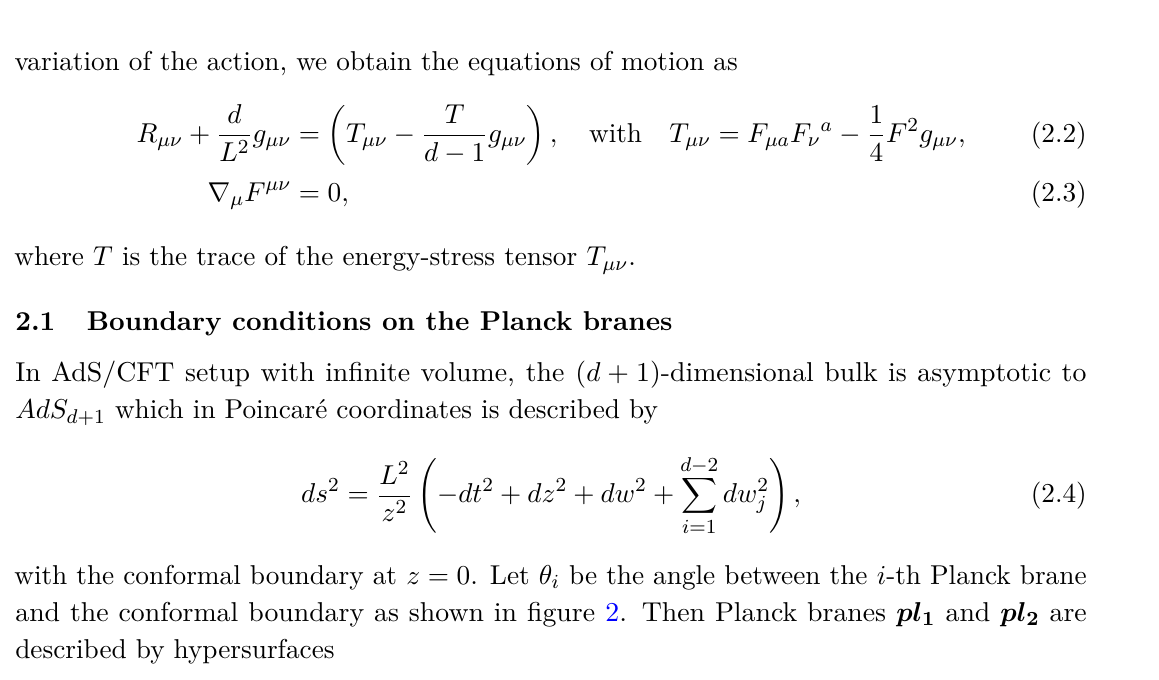
Figure 2 . A simple setup of Planck branes. Here Planck branes are anchored on the conformal boundary at ( z, w ) = (0 , 0) , ( z, w ) = (0 , w and θ 2